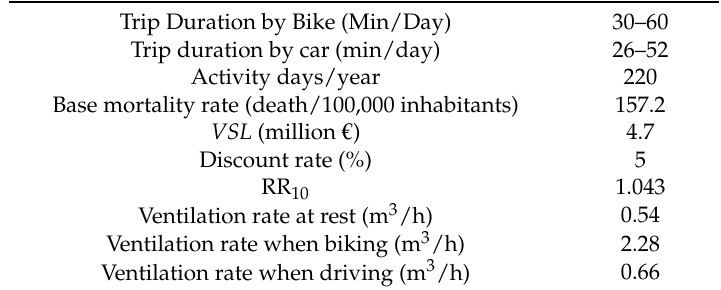
Table 1. Values of data input unchanged for different scenarios. VSL, standard value of statistical